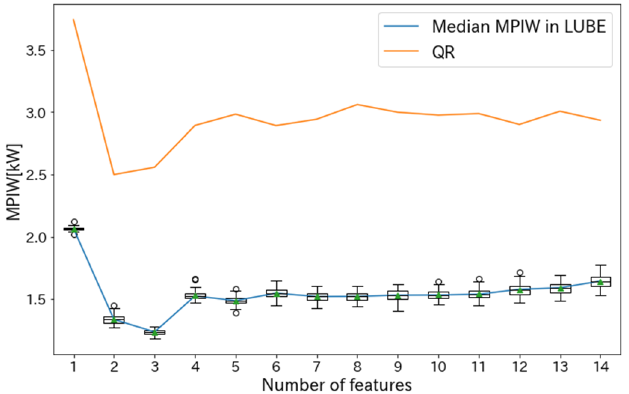
Figure 9. Histograms of 2-week average PICP for LUBE (1), (4), and (14).